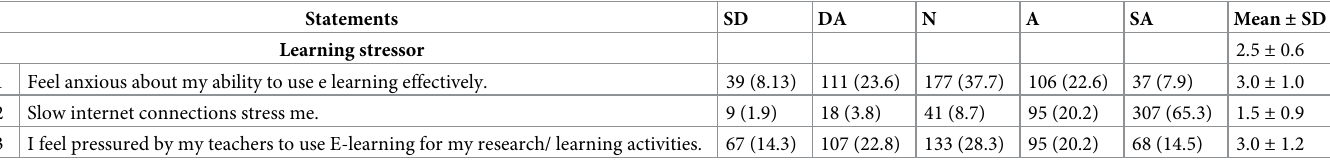
Table 7. Learning stressors (n = 470).